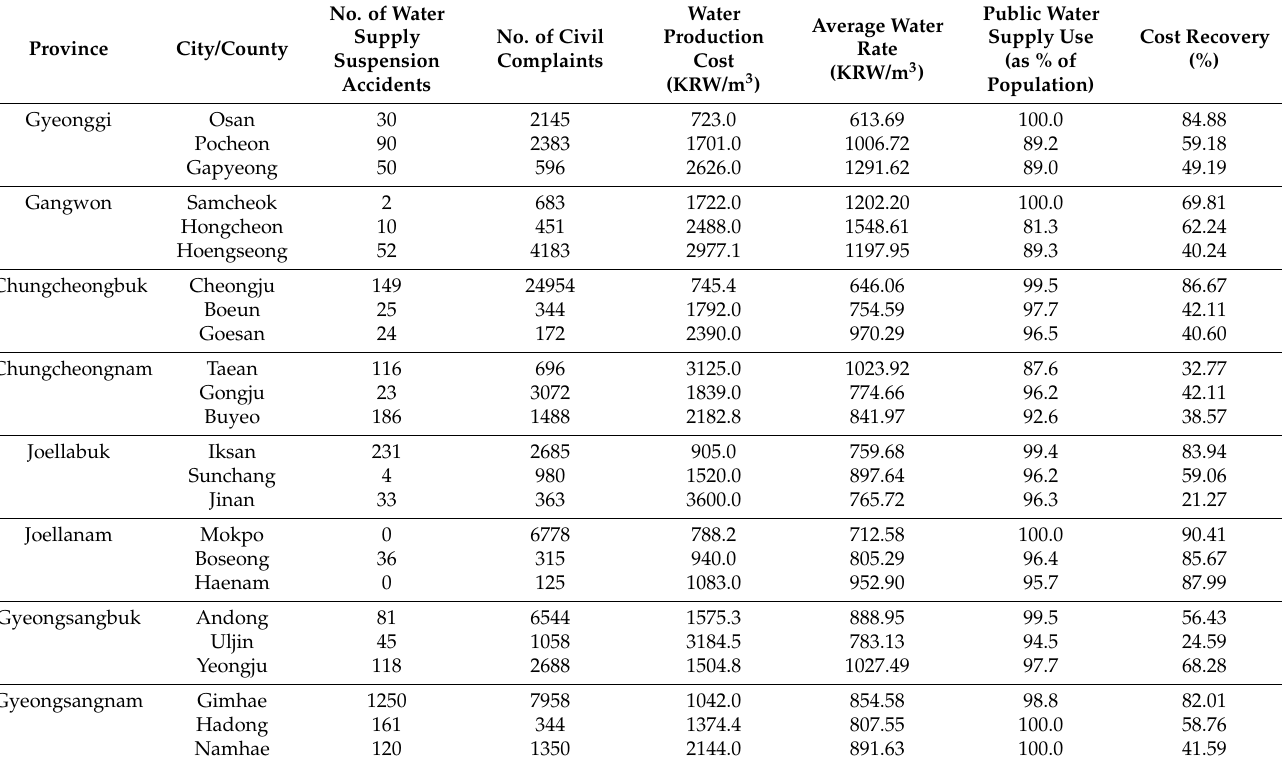
Table 1. Water supply service performance indicators for 24 survey sites in South Korea (1115.7 KRW = 1 USD).